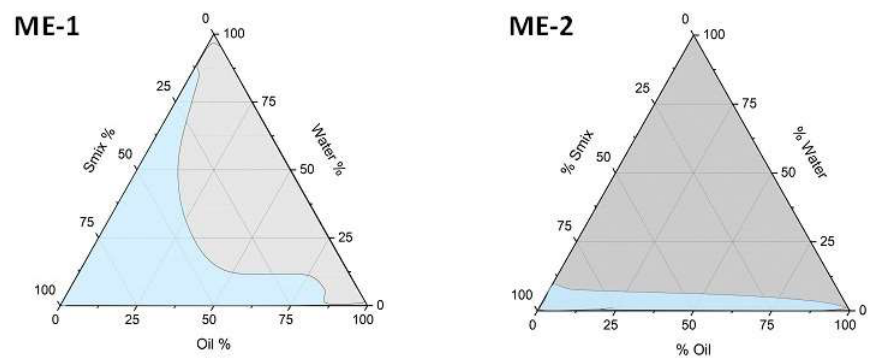
Figure 1. Pseudoternary phase diagrams of ME-1-OA and ME-2-OA. The ME domain (light blue) was determined by visual inspection. The rest of the region (grey) represents an emulsion (Figure 1). The final composition of the two MEs selected for OA loading is reported in Table 2. Table 2. Compositions ( w/w %) of ME formulations.